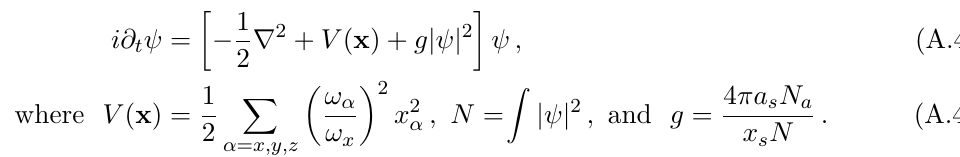
Table 1 . Typical physical values for various atomic Bose-Einstein condensates, and the resulting scale and dimensionless coupling. The reduced Planck constant is ~ = 1 . 05 × 10 − 34 J.s . Hence, after dropping the ˜ , the dimensionless Gross-Pitaevskii equation